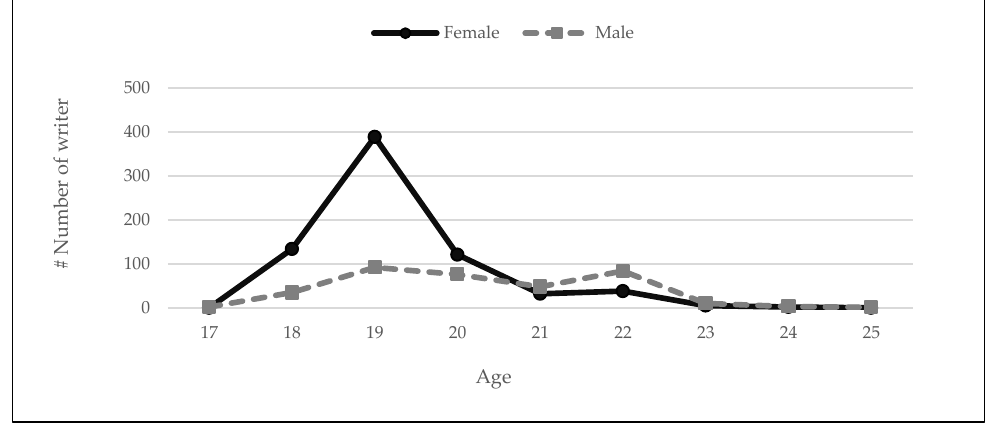
Figure 3. Statistics of age distribution about the writers.